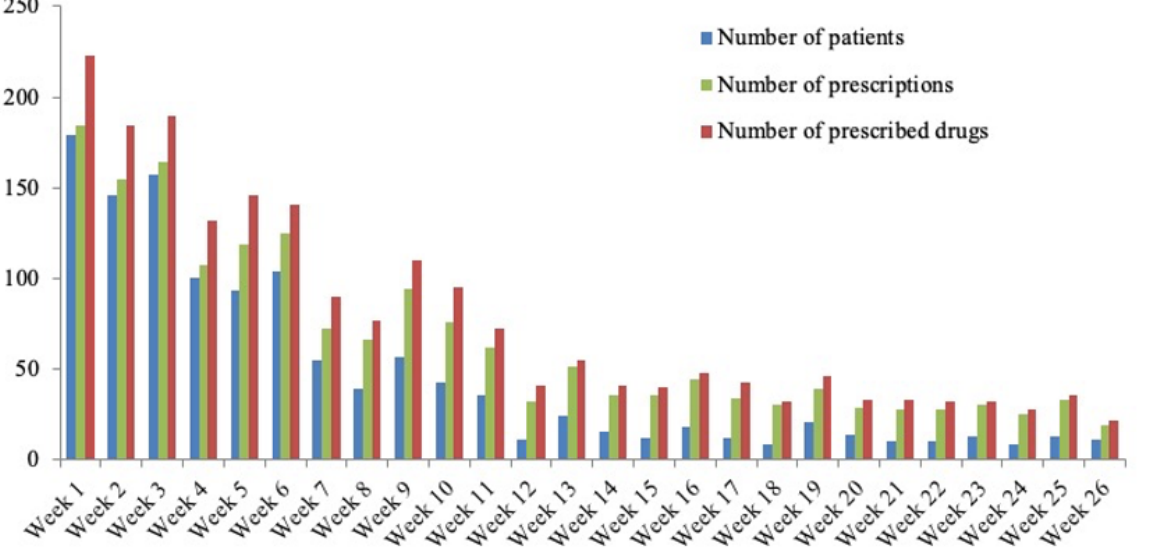
Figure 7. Weekly number of patients who used the remote prescription system, medication prescriptions ordered, and prescribed drugs delivered via the Cloud SYSUCC app since February 12,